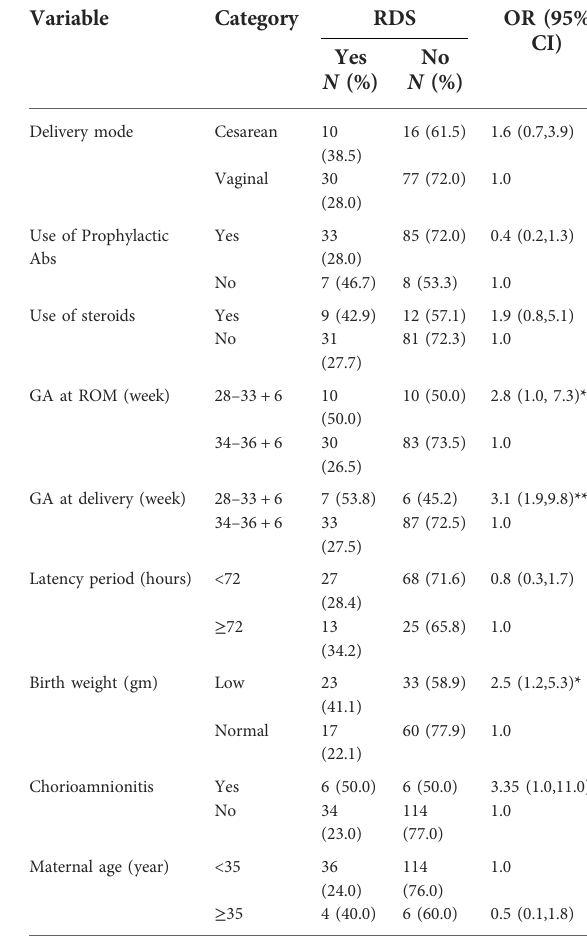
TABLE 5 Factors determining the development of RDS among pregnant women with preterm premature rupture of